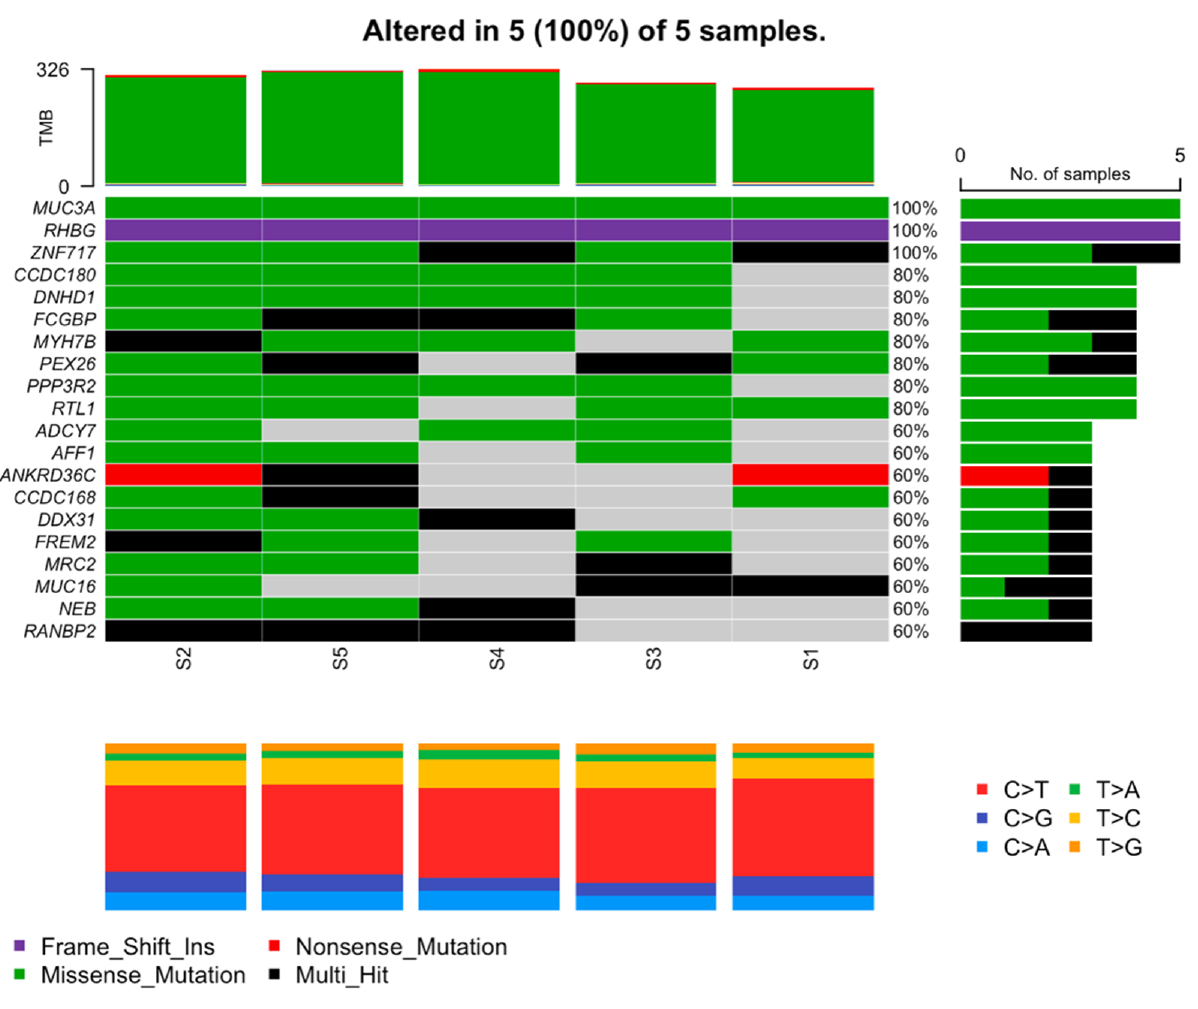
Table 2. Mutations in genes MUC3A, RHBG, and ZNF717. Gene